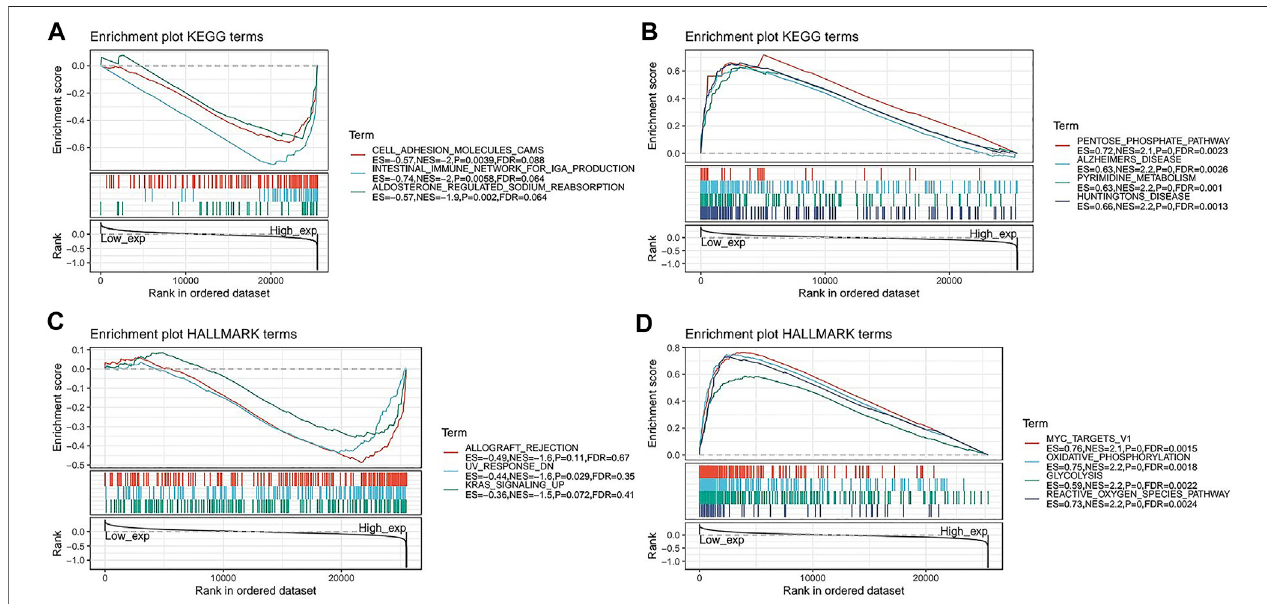
FIGURE 9 | Gene set enrichment analysis of FAM46C . Functional terms linked with FAM46C enrichment through (A,B) KEGG pathway analysis and (C,D) HALLMARK pathway analysis.